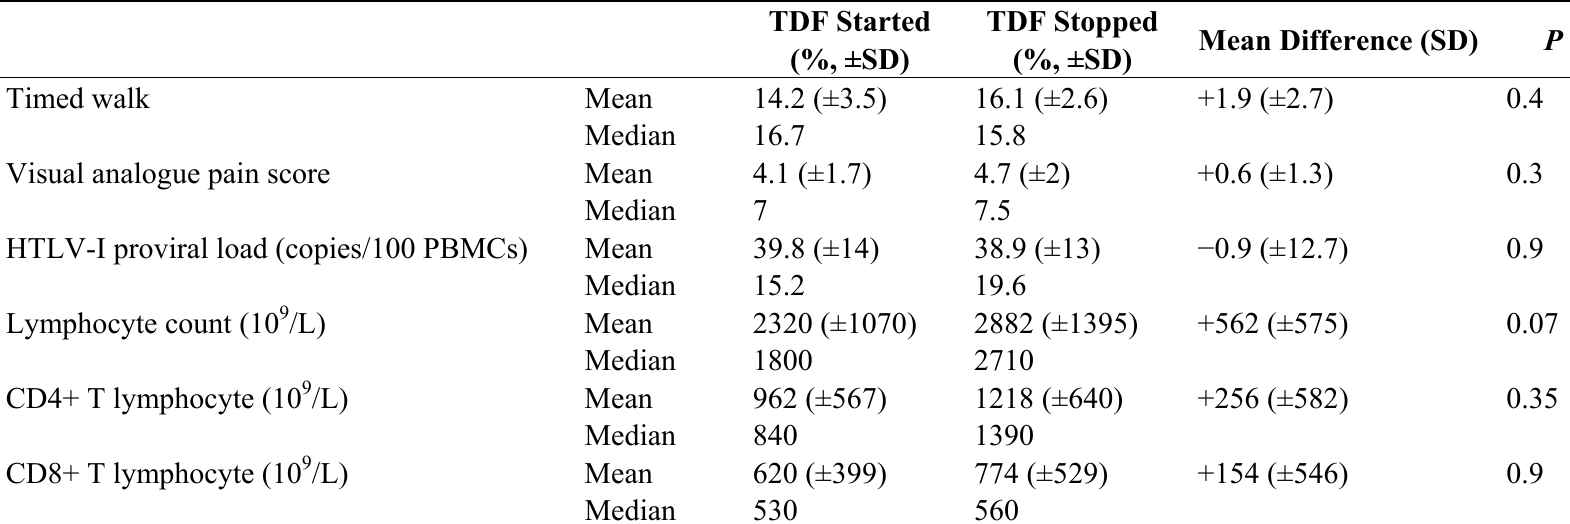
Table 3. Clinical, virological and immunological outcomes of patients with HAM receiving tenofovir (TDF) at baseline and at end of treatment.